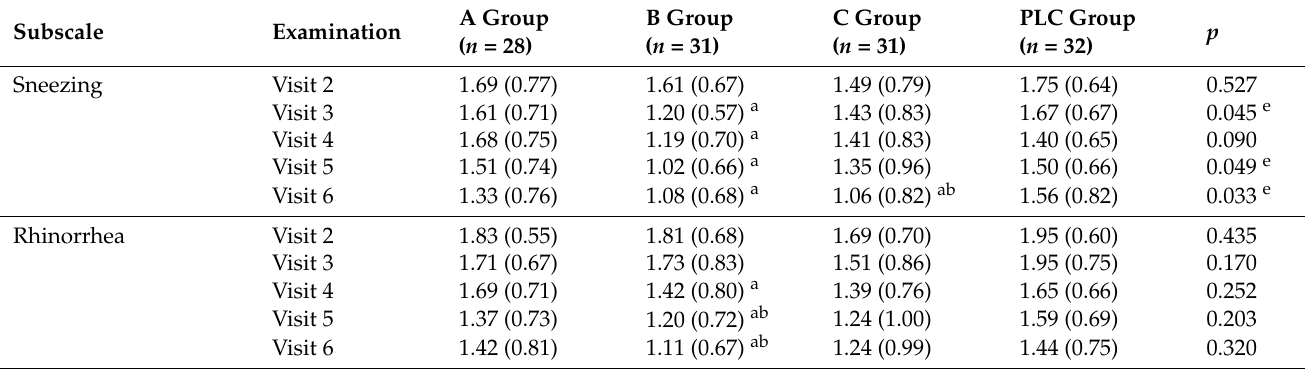
Figure 6. Effects of GM-080 consumption in OVA-specific antibodies or OVA-induced IL-5 production in an OVA-induced AHR mouse model. ( A – C ) Mice sera were collected 2 days after final theOVA challenge, and the presence of OVA-specific IgE ( A ), IgG1 ( B ), and IgG2a ( C ) was determined using ELISA. ( D – F ) Splenocytes were collected 2 days after the final OVA challenge and then seeded into a 48-well-plate at a density of 5 × 10 6 cells/well to determine IL-5 production without treatment ( D ) or after treatment with 2 µ g/mL ConA ( E ) or 100 µ g/mL OVA ( F ). NC, nontreated control; H 2 O, H 2 O gavage; LP-L, GM-080 at 2 × 10 6 CFU/mouse/day through gavage; LP-H, GM-080 at 1 × 10 7 CFU/mouse/day through gavage. * p < 0.05, ** p < 0.01. Table 4. AR symptom scores at baseline and follow-up visits among enrolled patients #